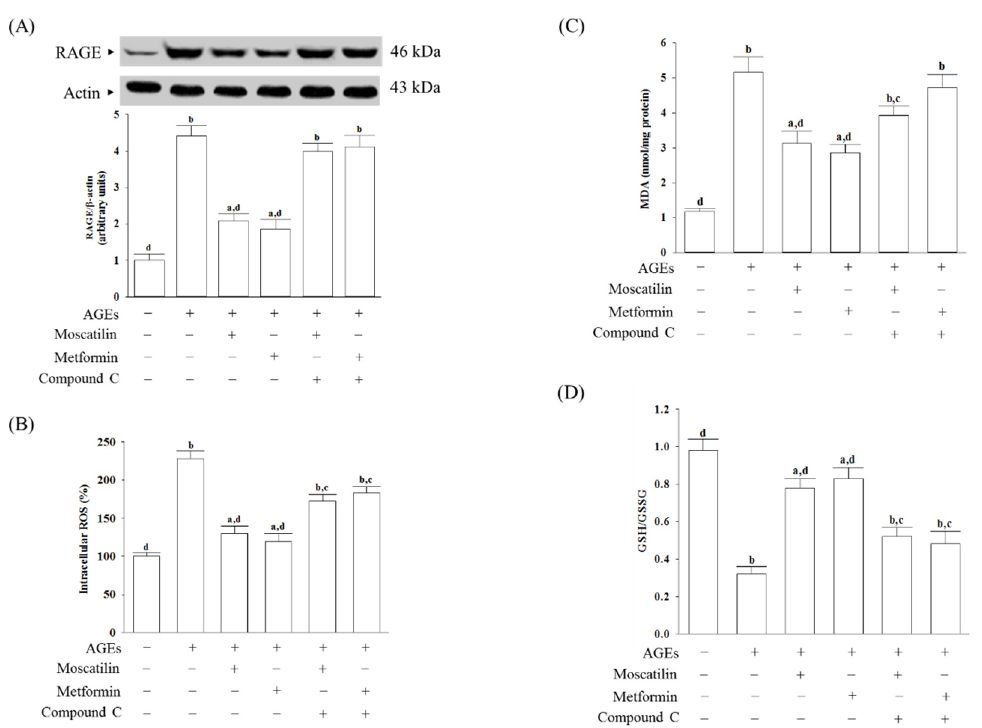
Figure 2. Changes in cell-surface receptors (RAGE) expression and oxidative stress-related factors induced by AGEs in SH-SY5Y cells. Cells were pretreated with moscatilin (1 µ mol / L) or metformin (2 µ mol / L) for 1 h, followed by exposure to 50 µ g / mL AGEs for another 24 h. Compound C (5 µ mol / L) was added 1 h before moscatilin or metformin were stimulated. ( A ) The expression of RAGE protein level was determined by Western blot. The densities of protein bands were quantitated and listed in the bottom panels. ( B ) Intracellular ROS production was measured using the oxidation-sensitive fluoroprobe DCFH-DA ( C ) The estimation of accumulated MDA by a thiobarbituric acid test as a measure of lipid peroxidation. ( D ) The cellular GSH-to-GSSG ratio was determined by qualified commercial assay kits. The results are presented as the mean ± SD of five independent experiments ( n = 5), each of which was performed in triplicate. a p < 0.05 and b p < 0.01 compared to the data from untreated group (vehicle control). c p < 0.05 and d p < 0.01 when compared to the data from cells cultured under AGEs without any treatment.